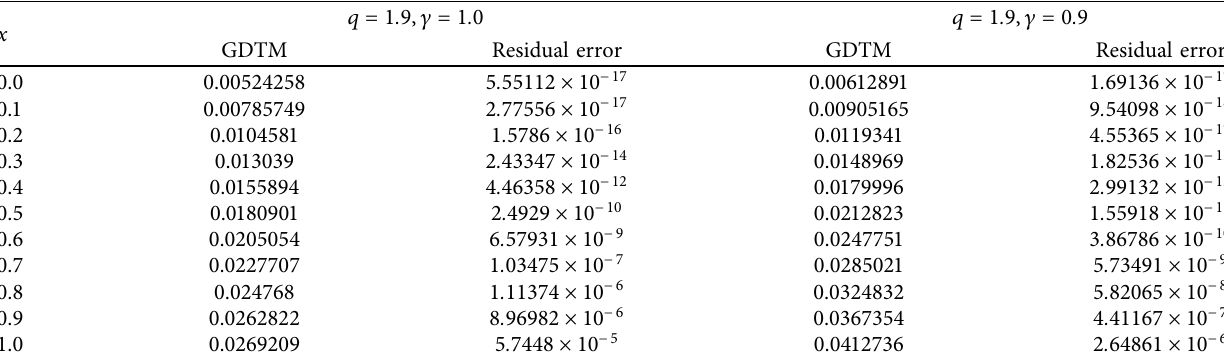
Table 4: Numerical outputs for λ � 5 , μ � 0 . 05 , β � 0 .